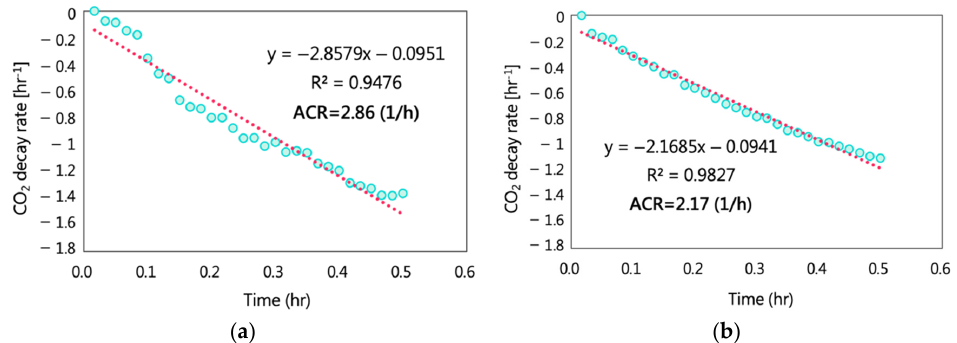
Figure 10. The relationship between decay rate of CO 2 concentration and time: ( a ) Scheme one; ( b ) Scheme two.